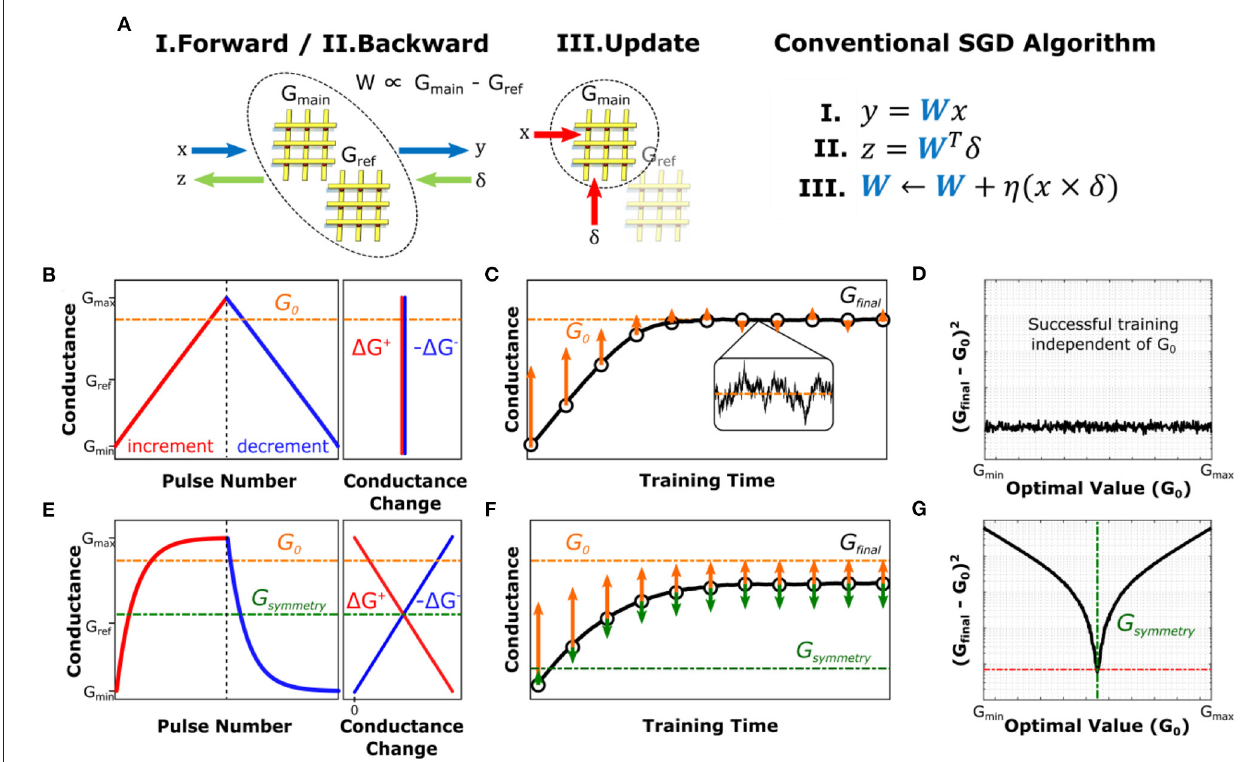
FIGURE 1 | Effect of asymmetric conductance modulation for SGD-based training. (A) Schematic and pseudocode of processes for conventional SGD algorithm ( Cauchy, 1847). Vectors x , y , represent the input and output vectors in the forward pass whereas δ , z contain the backpropagated error information. The analog architecture schematic is only shown for a single layer, where all vectors are propagated between upper and lower network layers in general. The pseudocode only describes operations computed in the analog domain, whereas digital computations such as activation functions are not shown for simplicity. (B) Sketch of conductance modulation behavior of a symmetric crosspoint device. (C) Simulated single-parameter optimization result for the symmetric device shown in (B) . conductance successfully converges to the optimal value for the problem at hand, G 0 . (D) Simulated residual distance between the final converged value, G final , and G 0 for training the device with characteristics shown in (B) for datasets with different optimal values. (E) Sketch of conductance modulation behavior of an asymmetric crosspoint device. The point at which 1 G + = 1 G − is defined as the symmetry point of the device ( G symmetry ) (F) Simulated training result for the same single-parameter optimization with the asymmetric device shown in (E) . Device conductance fails to converge to G 0 , but instead settles at a level between G 0 and G symmetry . (G) Simulated residual distance (in semilog scale) between the final value, G final , and G 0 for training the device with characteristics shown in (E) for datasets with different optimal